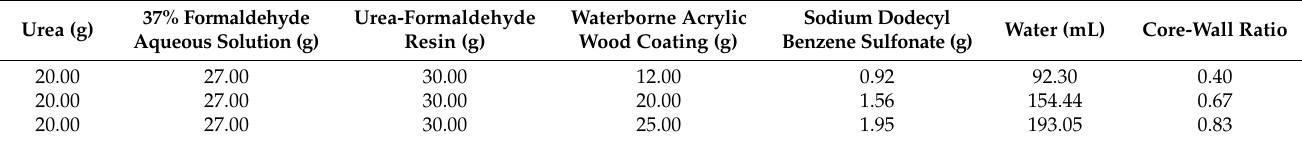
Table 1. Microcapsule raw material ratio